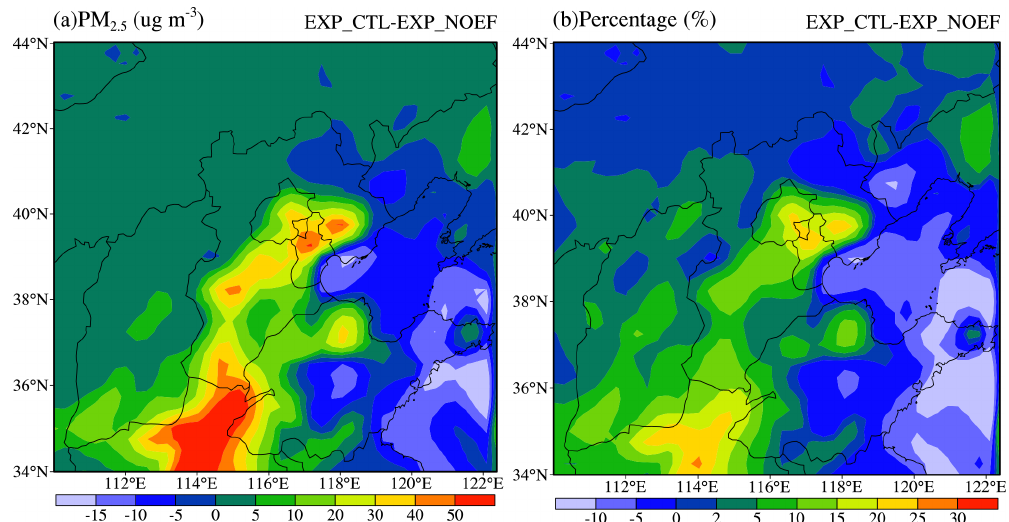
Figure 12. (a) Spatial distribution of the surface PM 2 . 5 concentration change (µgm − 3 ) induced by meteorological variable change averaged over 09:00–18:00 during 10–15 January 2013. Panel (b) shows the change in percentage terms compared to the surface PM 2 . 5 concentration from the model results of